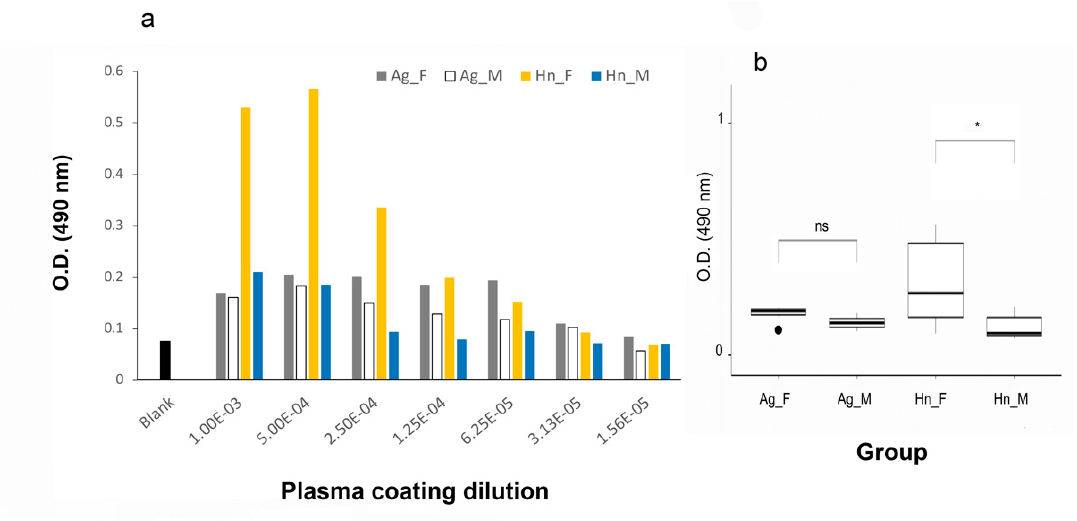
Figure 5. Dilution series of male and female Pirarucu, Arapaima gigas , and African bonytongue , Heterotis niloticus , plasmas revealed with Heterotis niloticus Vtg antibodies in ELISA, ODs at 490 nm. Blank (plate + reagents background) received all reagents except the coating one ( a ). Box plots of Statistical analysis of ODs by ANOVA, rstatix ( b ). * indicates significant statistical differences between male and female coating dilutions range ( p = 0.024); ns indicates non-significant difference ( p = 0.93), Tukey HSD with p adjust. Ag_F: A. gigas female; Ag_m: Arapaima gigas male; Hn_F: Heterotis niloticus female; Hn_M: Heterotis niloticus male.